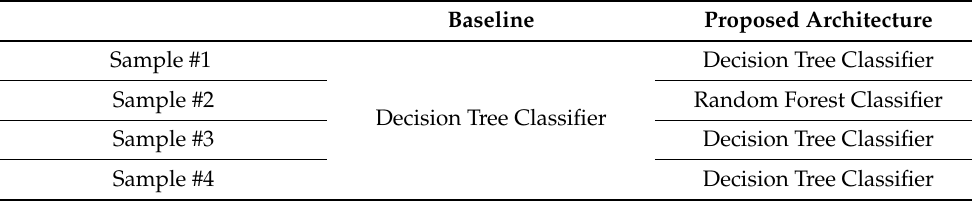
Table 6. Models used for the baseline and the proposed architecture